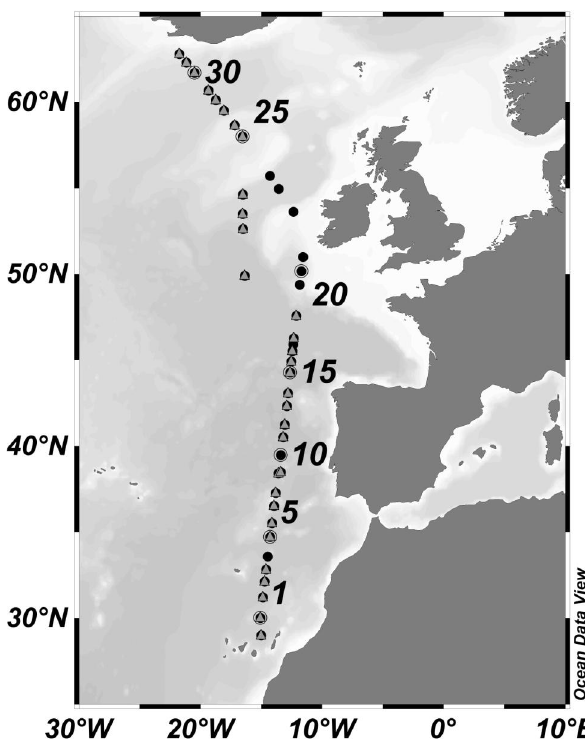
Fig. 1. Sample locations of the spring (2011, triangles) summer and (2009, circles) Stratiphyt cruises. The numbers represent the station numbers.